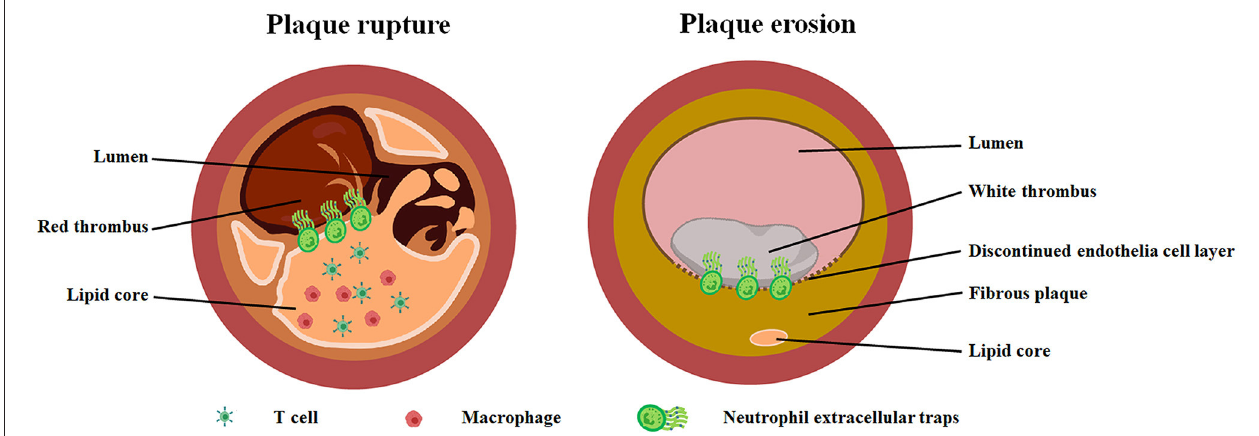
FIGURE 1 | Pathological characteristics of plaque rupture and plaque erosion. Ruptured plaque (left image) is featured with a larger lipid core containing abundant macrophages and T cells. Red thrombus was observed in the small lumen. Eroded plaque (right image) has a large lumen with white thrombus and fibrous plaque tissue characterized by little or no lipid deposition. In particularly, there is discontinuous endothelial cell layer in eroded plaque. Neutrophil extracellular traps was found at the junction of plaque tissue and thrombus in both eroded and ruptured